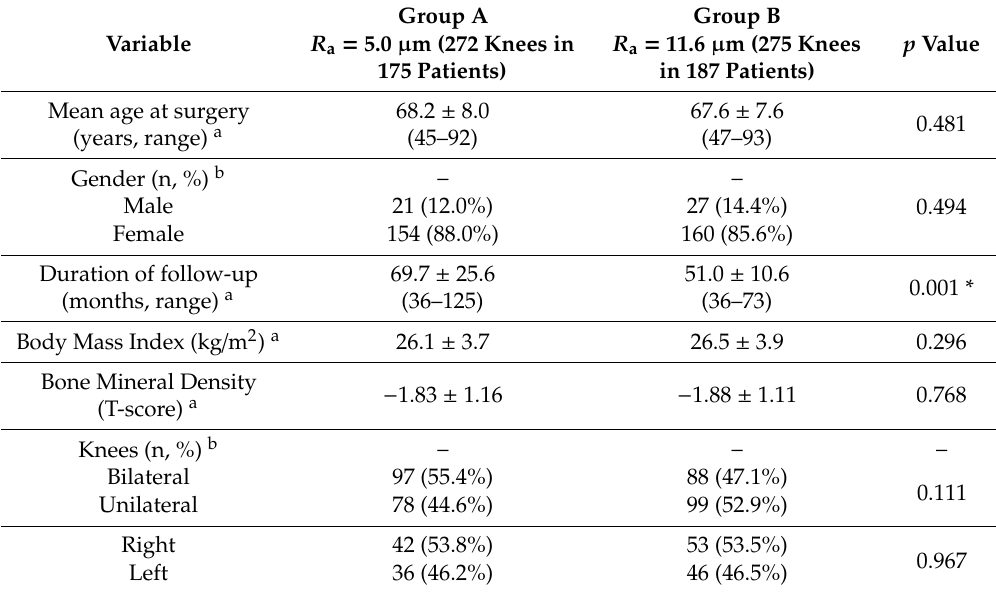
Table 1. Patient demographic